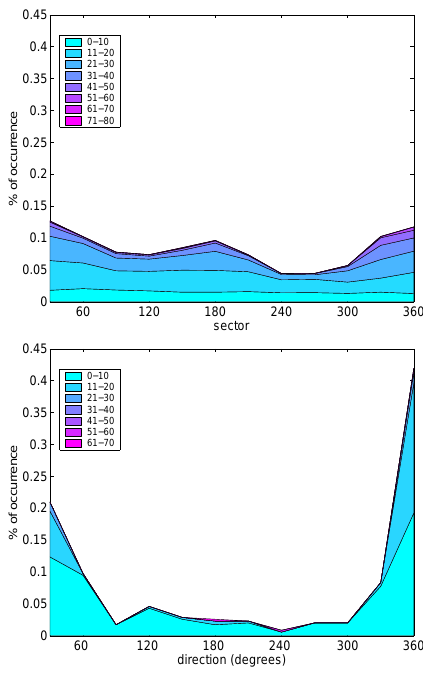
Fig. 13. Direction against percentage of occurrence for the current speed at location corresponding to VEINS FA/FB. Model (top) and observational (bottom) ata are shown at about 300m